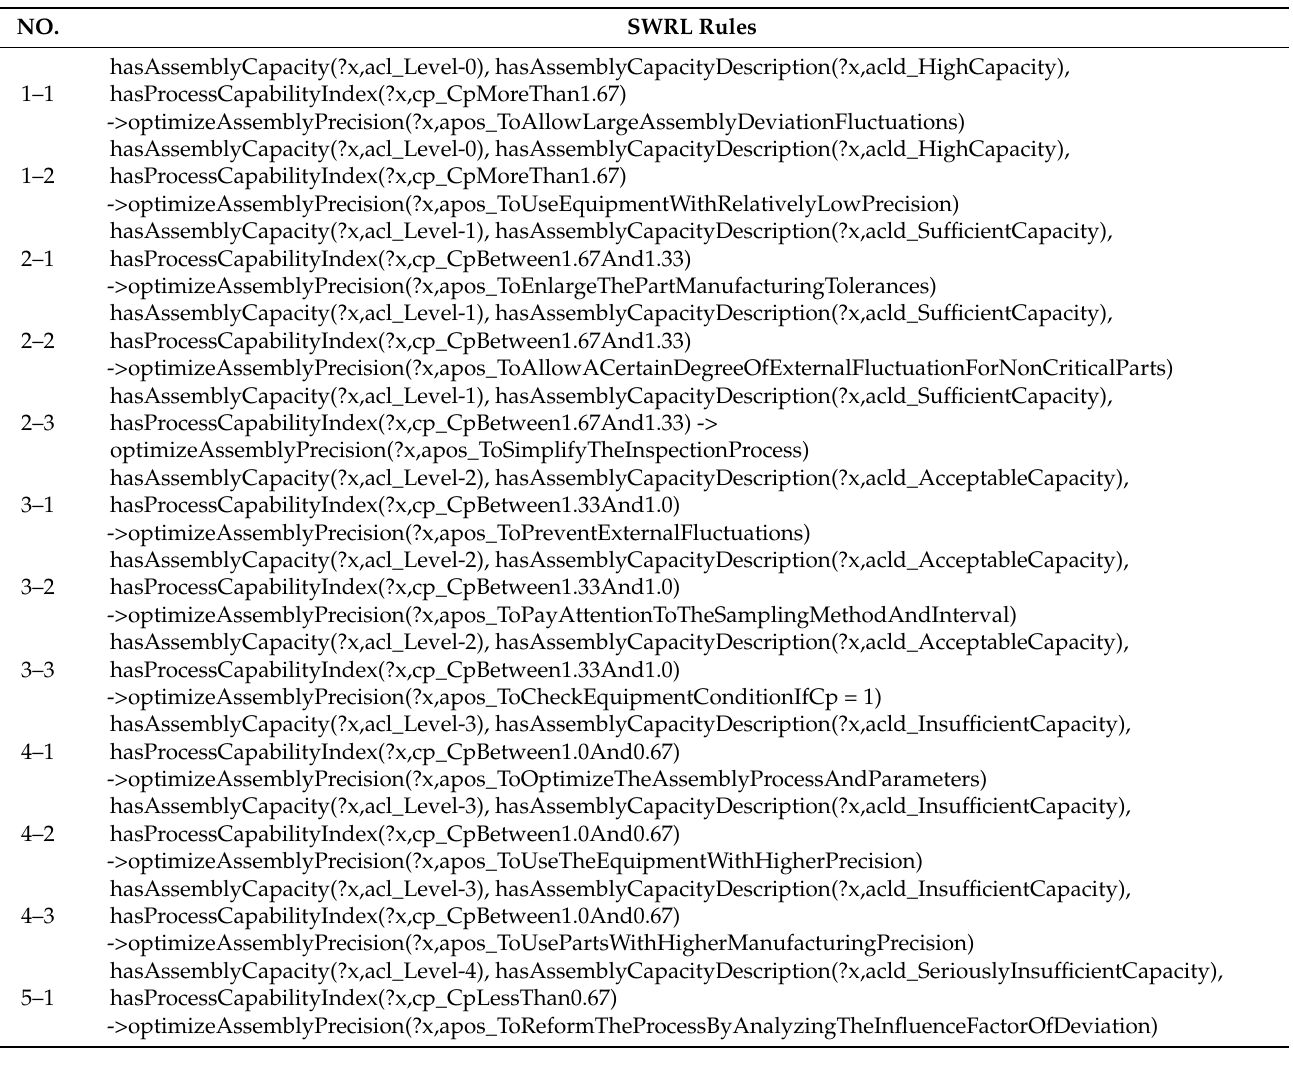
Table 4. SWRL rules of characterization value